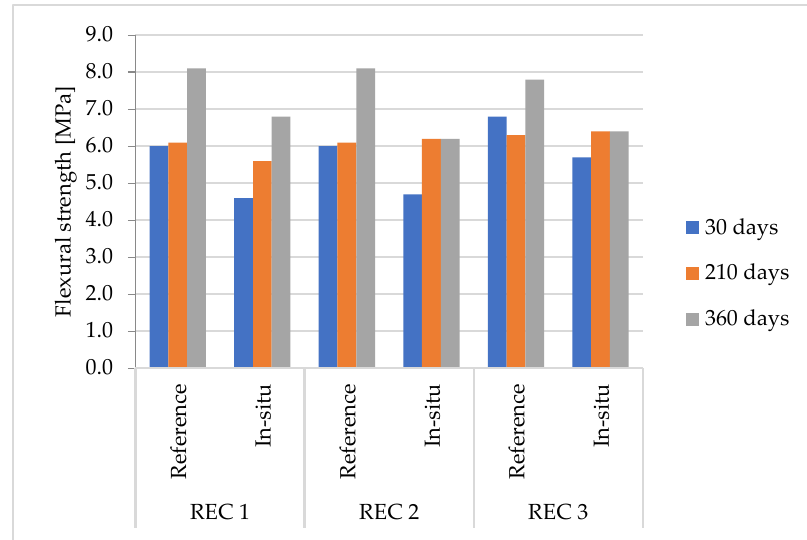
Figure 6. Flexural strength of mixtures. Table 6. Results of basic physical and mechanical properties for Series